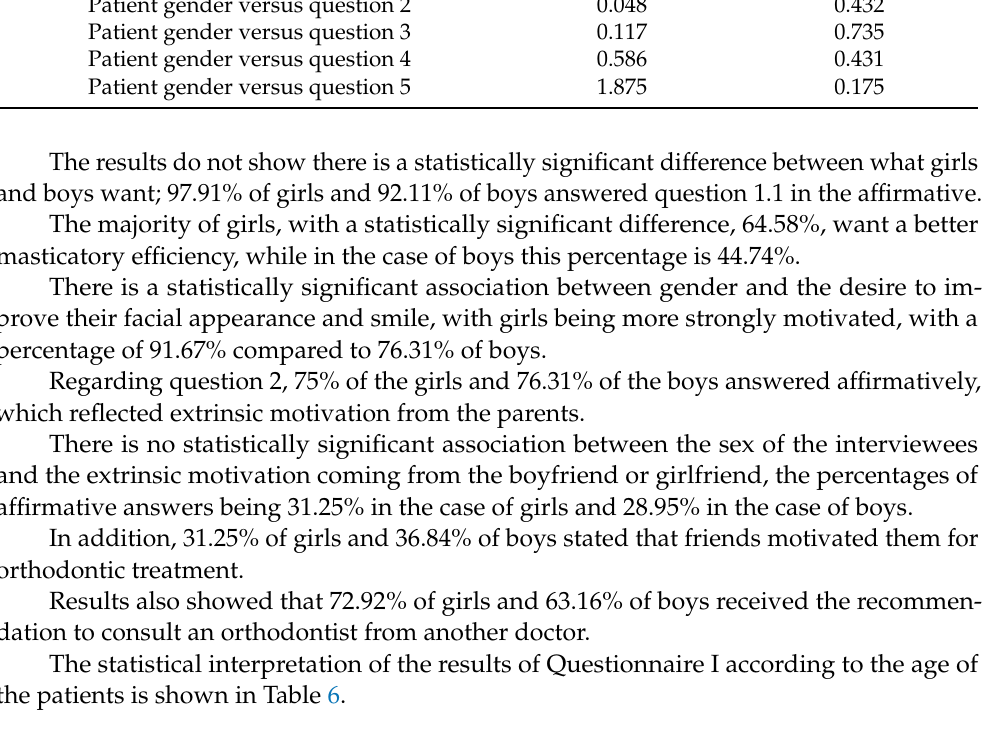
Table 5. The results of Questionnaire II according to the gender of the subjects. Chi 2 p -Value Patient gender versus question 1.1 3.234 0.066 Patient gender versus question 1.2